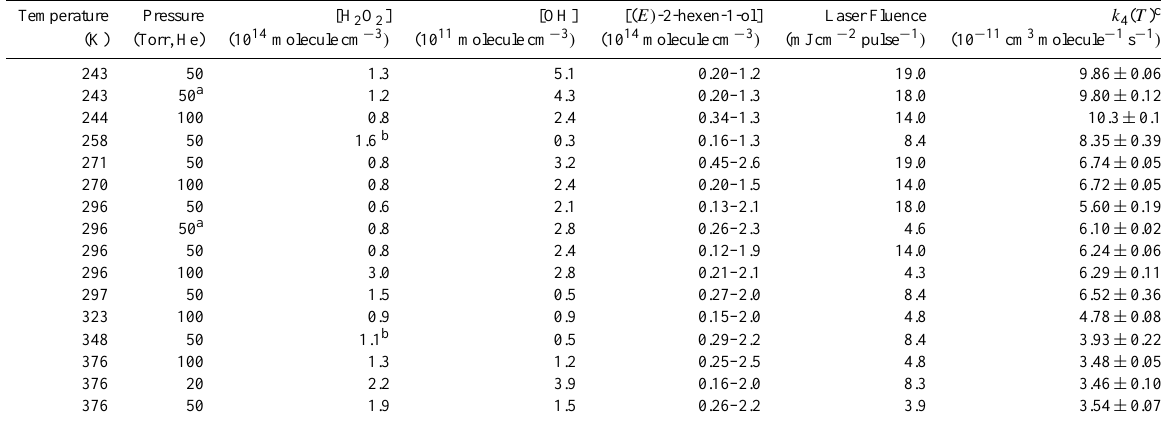
Table 5. Summary of experimental conditions and measured rate coefficients, k 4 ( T ), for the OH+( E) -2-hexen-1-ol reaction.